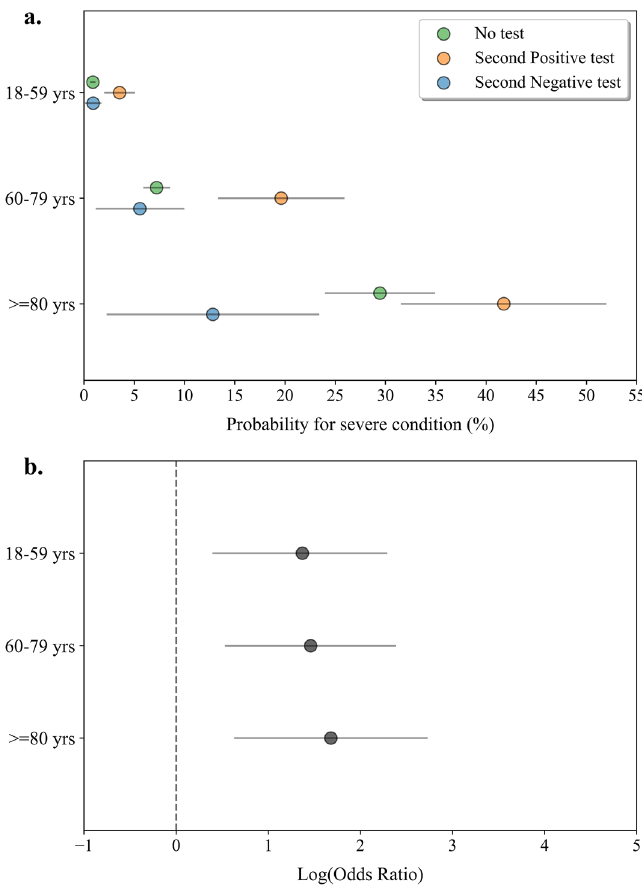
Figure 1. Deterioration probability and odds ratio analysis for SARS-CoV-2 positive individuals following a second NP PCR test. ( a ) Probability for severe COVID-19 in infected individuals tested a second time within the first week following diagnosis. Blue circles represent individuals who tested negative, orange circles represent individuals who tested positive and green circles represent individuals who were not tested in the week following diagnosis. Grey lines indicate 95% confidence intervals. ( b ) Log odds ratio (OR) for severe COVID-19 was calculated by the result of a second PCR test taken up to a week following diagnosis in a defined age group (18–59 years, n = 1287; 60–79 years, n = 266; > = 80 years, n = 130). OR > 0 indicated larger risk in the population that tested positive compared to the population tested negative. Calculated log odds ratios are presented along with gray lines indicating 95% confidence